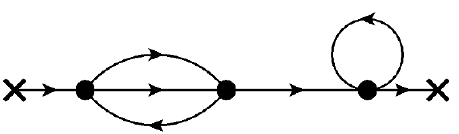
Figure 1 . The diagram corresponding to the invariant eq. (2.19). (In [35], the precise relation between invariants and diagrams is